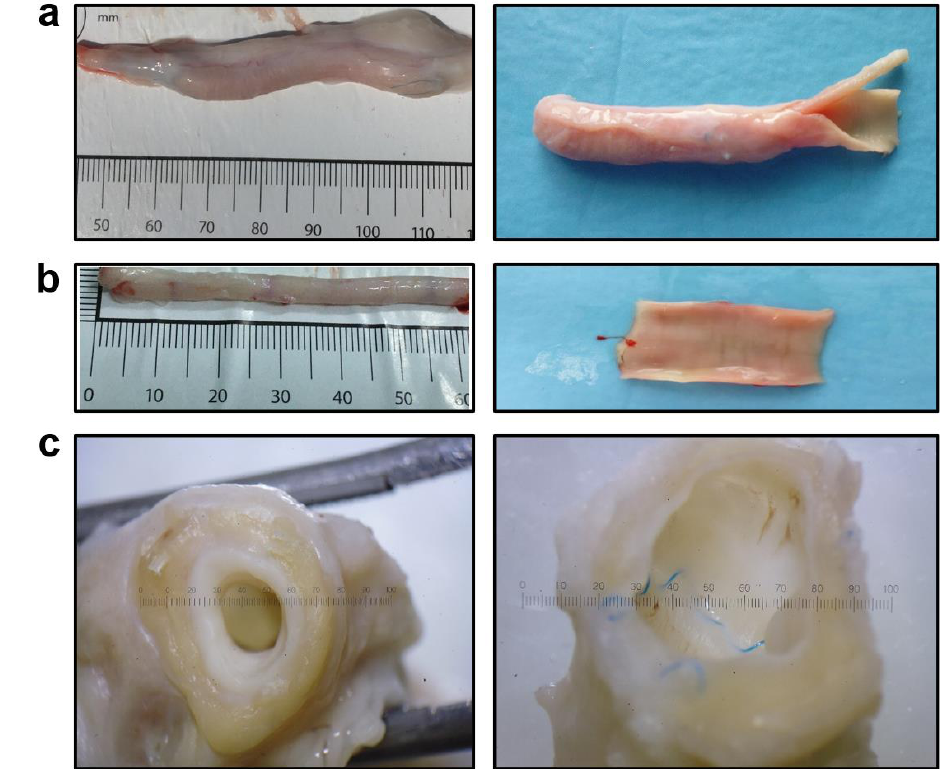
Figure 6. Gross examination of PCL Ilo/CAD TEVGs and contralateral healthy carotid arteries 6 months postimplantation. ( a ) PCL Ilo/CAD TEVG, intact (left) and longitudinal section to show the luminal surface (right), ×10 magnification; ( b ) Contralateral healthy carotid artery, intact (left) and longitudinal section to show the luminal surface (right), ×10 magnification; ( c ) A cross-section view showing the similarity of TEVG and anastomotic site luminal surfaces.